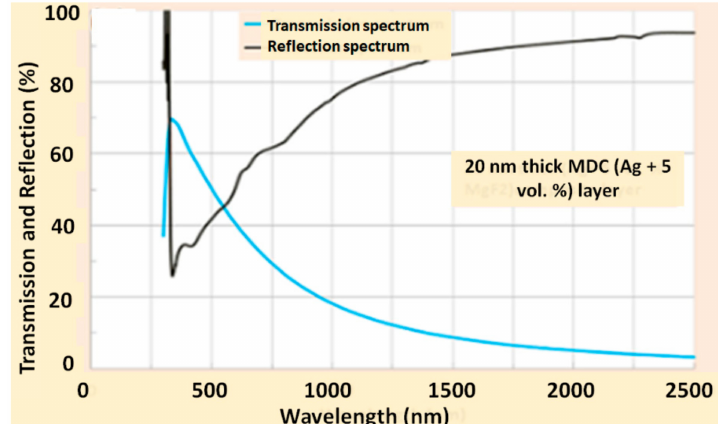
Figure 9. Measured transmission and reflection spectra of ~20 nm thick Ag + 5 vol. % MgF 2 composite layer, deposited onto glass